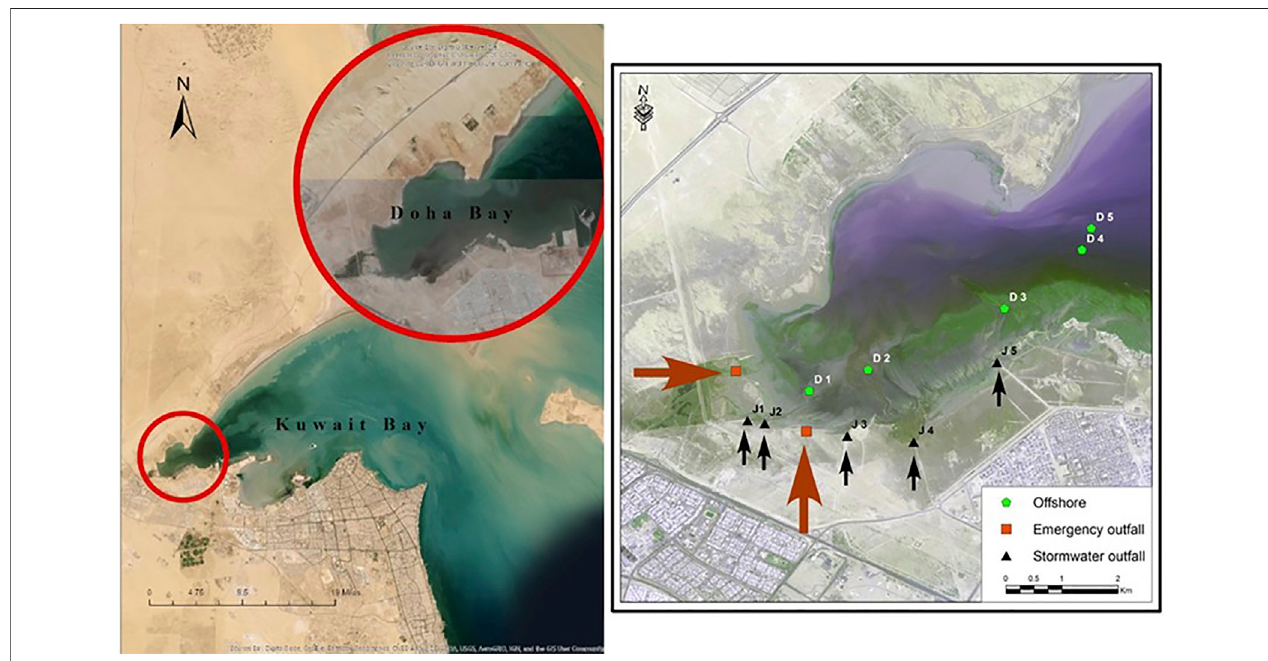
FIGURE 3 | Doha Bay and stormwater and emergency outfalls and offshore sampling sites D1 – 5.